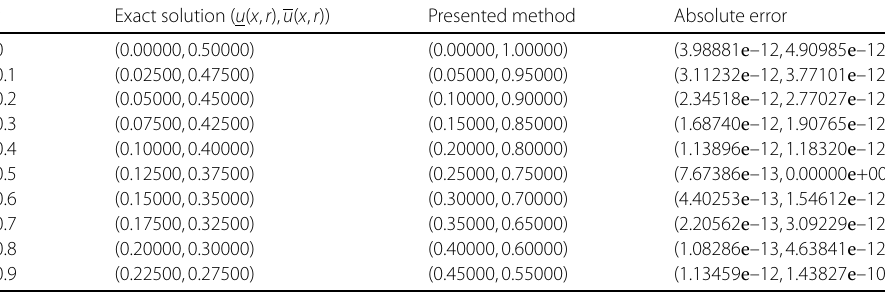
Table 4 The numerical results for Example 4 with x = 0.5, M = 2, N =